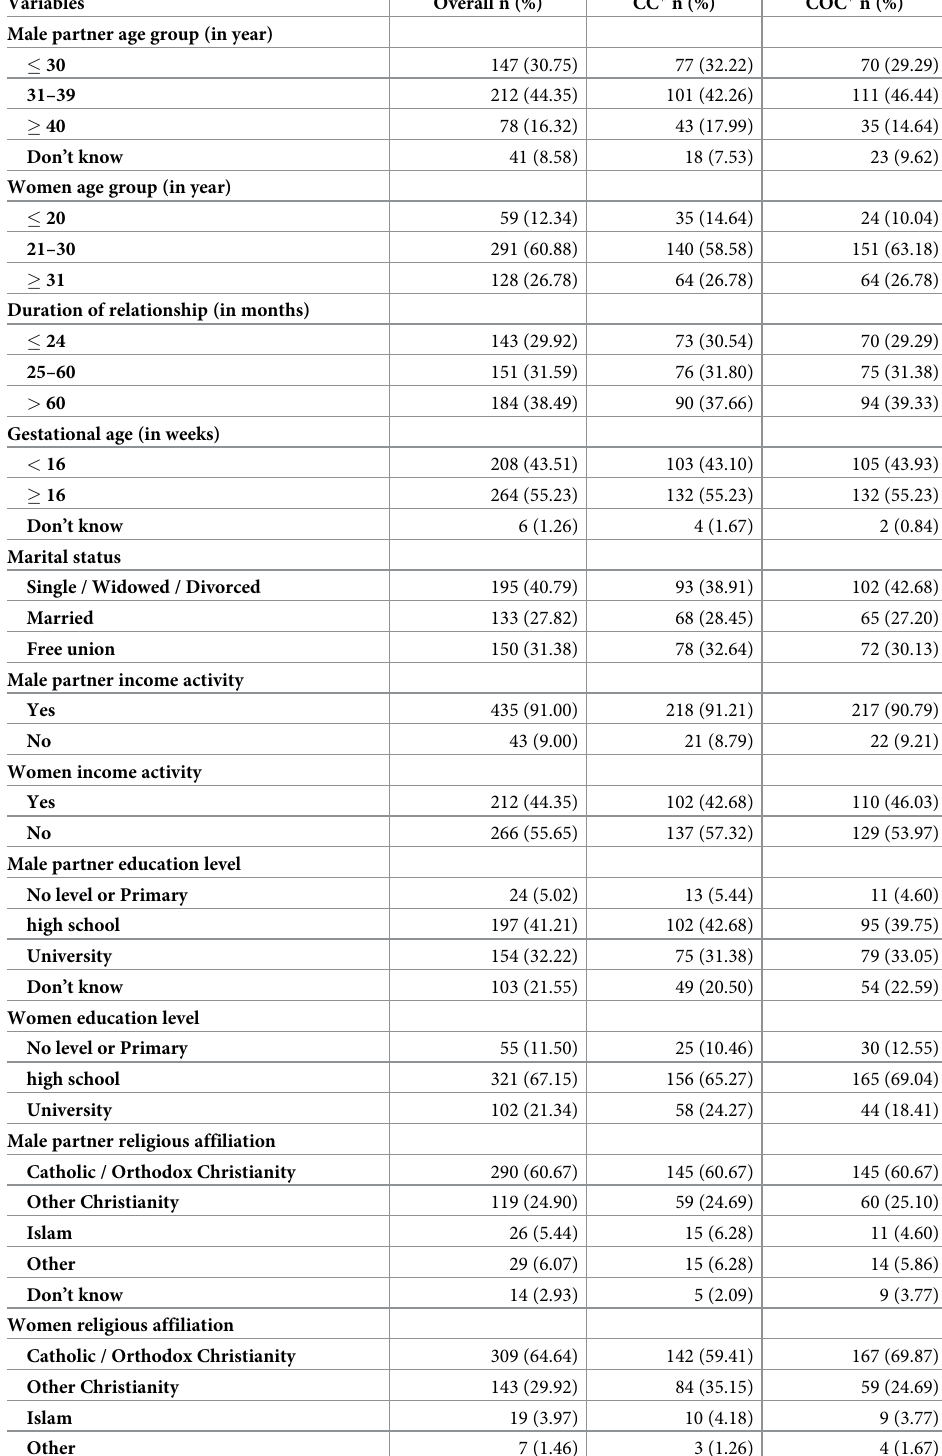
Table 1. Socio-demographics characteristics of couples at inclusion according to the counselling group within the ANRS 12127–12236 trial cohort Prenahtest, Cameroon, 2009–2011; (N =